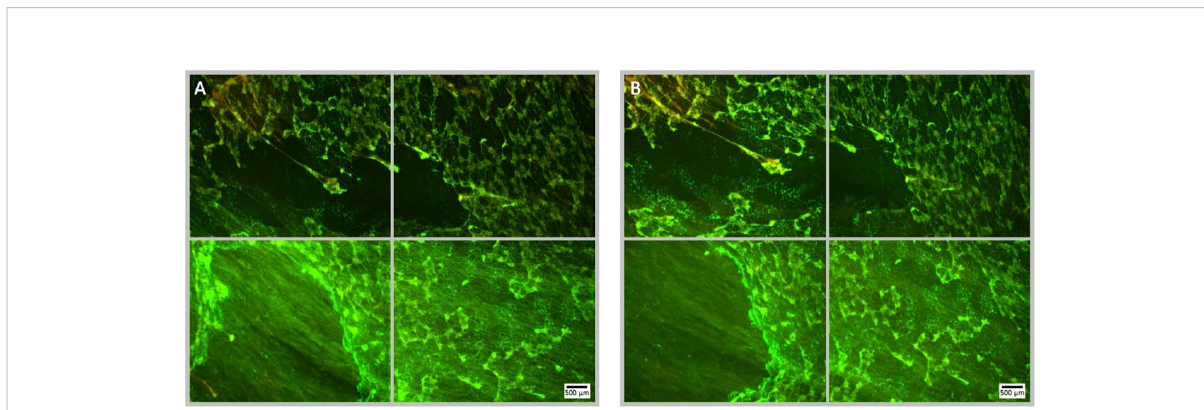
FIGURE 3 Fluorescence microscopy images of a Syto9 (green) and PI (red) stained P. aeruginosa bio fi lm; the images are representative of a no ultrasound, no antibiotic control where MBs were applied, but not stimulated with ultrasound. Each panel is comprised of four images, which provide an overview of the bio fi lms gross architecture in a 1 cm 2 area at the centre of the Ibidi ® dish. Panel (A) , depicts the pre-treatment images of the 1 cm 2 area of bio fi lm, captured prior to the administration of the MB suspension; scale bar is equal to 500 µm. Panel (B) , depicts the post- treatment images of the same 1 cm 2 area of bio fi lm, captured after the administration and removal of MBs from the Ibidi ® dish.